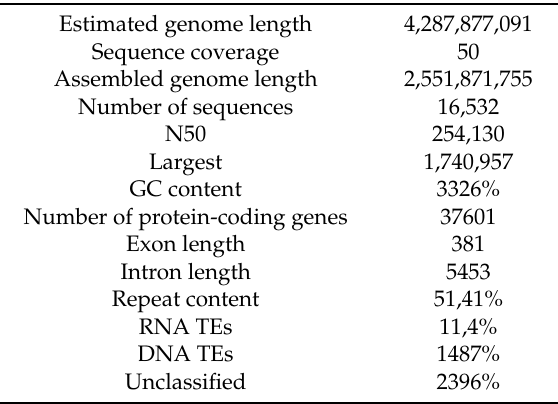
Table 1. Summary of genome